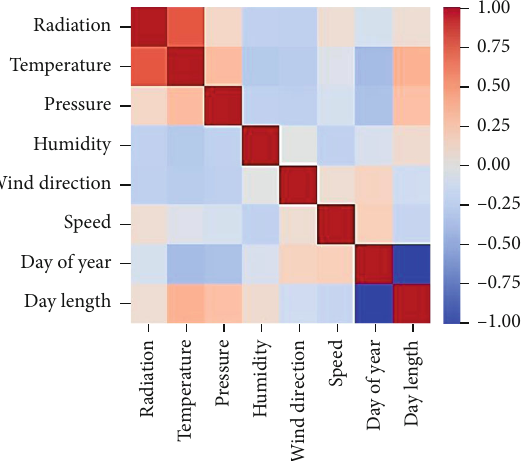
Figure 6: Correlation Pearson plot of the BIPV